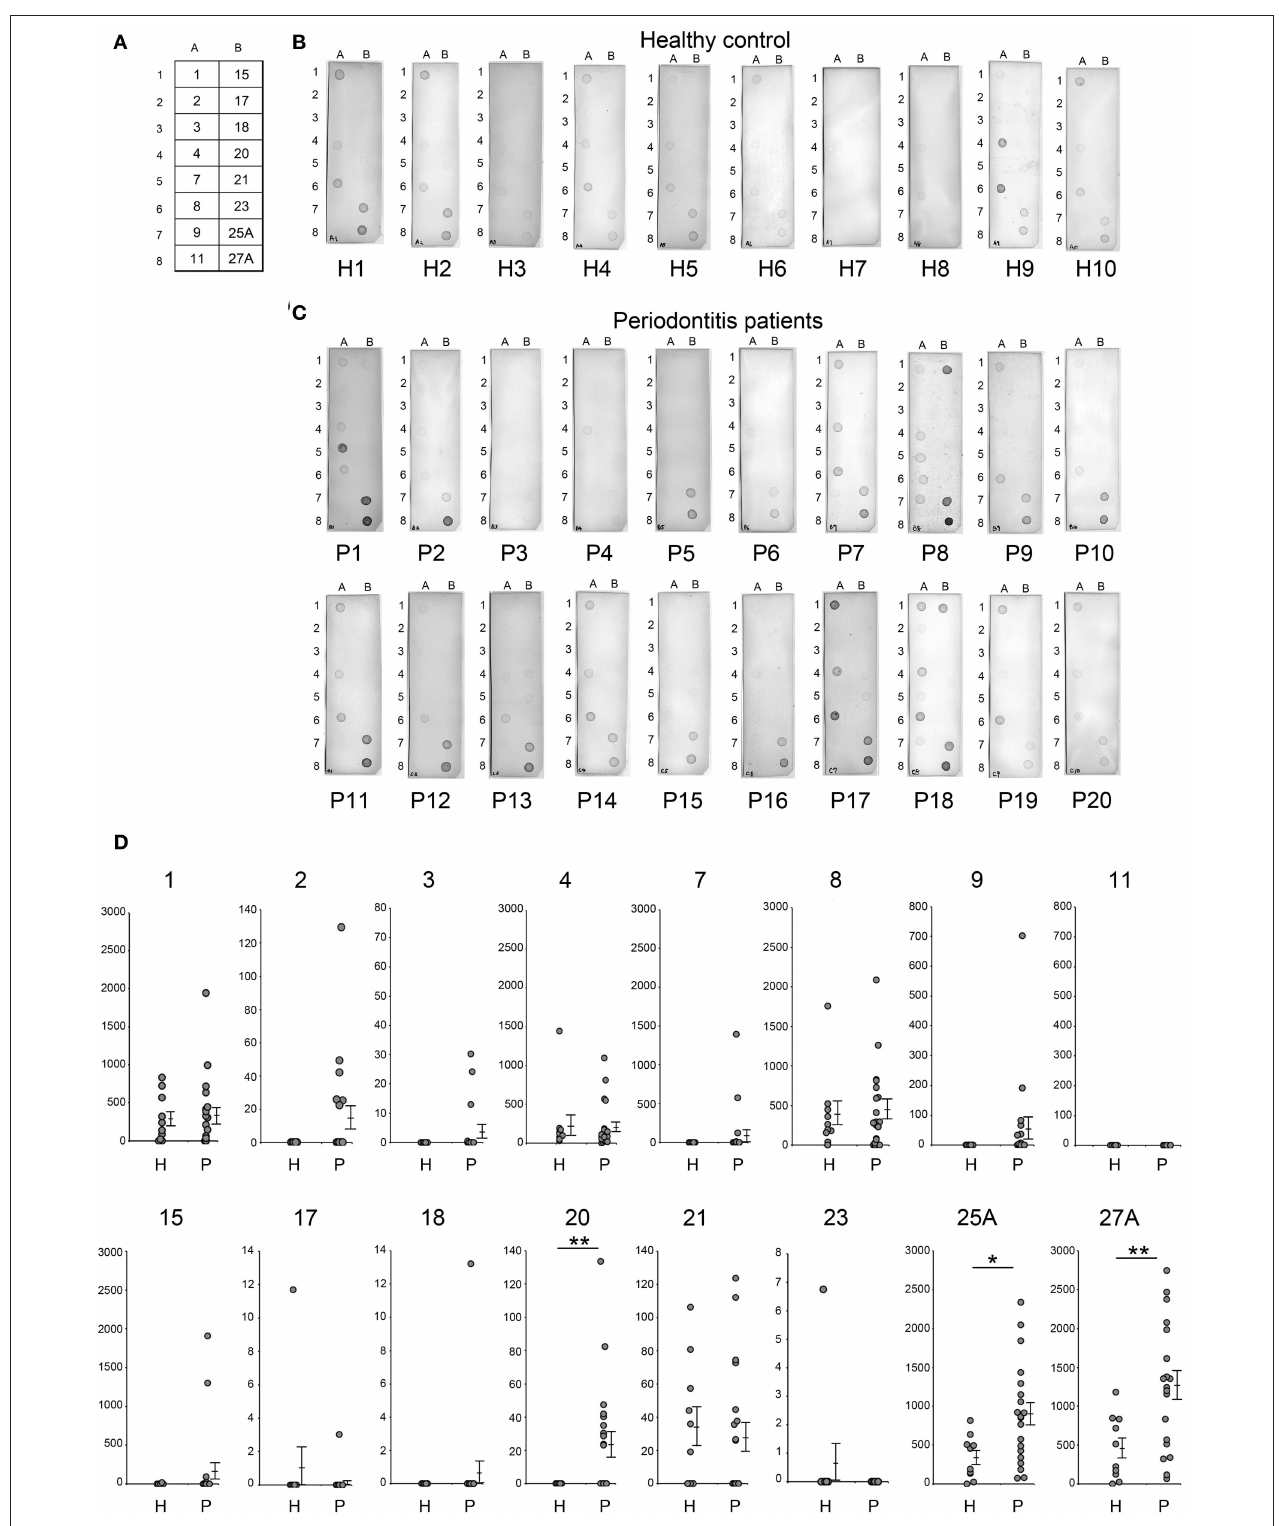
FIGURE 4 | Analysis of serum IgG responses to recombinant antigens. (A) The panel shows a schematic of the proteins spotted on the membrane used for dot blotting. The numbers exhibited on the panel were recombinant protein numbers shown in Table 2 . The results of individual serum from healthy controls ( B : H1–H10) and patients with periodontitis ( C : P1–P20) have been shown. The 20 periodontitis patients that comprised this experiment included 10 patients each with mild